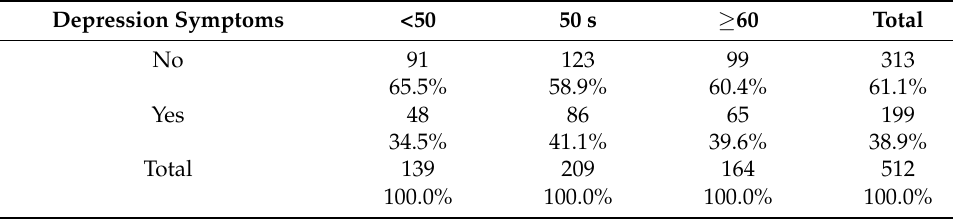
Table 3. Distribution of depression symptoms by age group